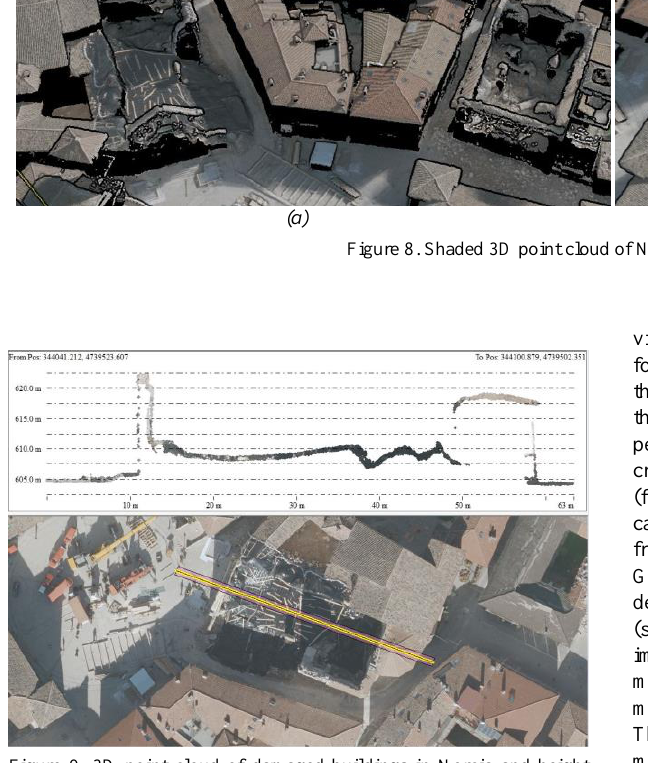
Figure 9. 3D point cloud of damaged buildings in Norcia and height profile along a section.